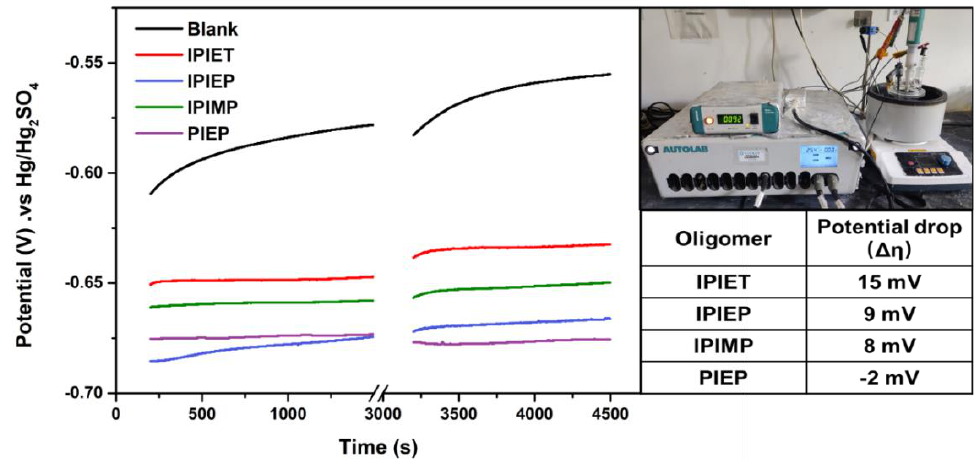
Figure 1. GMs of various oligomer-containing solutions at a current density of 1.5 A/dm 2 . The rotation speeds of Cu-RDE are 2500 rpm (0~1500 s) and 200 rpm (3000~4500 s). Each bath is composed of base electrolyte, 5 g/L PEG, 10 mg/L SPS, and 5 mg/L oligomer, respectively. The insets show the instrument and the values of potential drops.